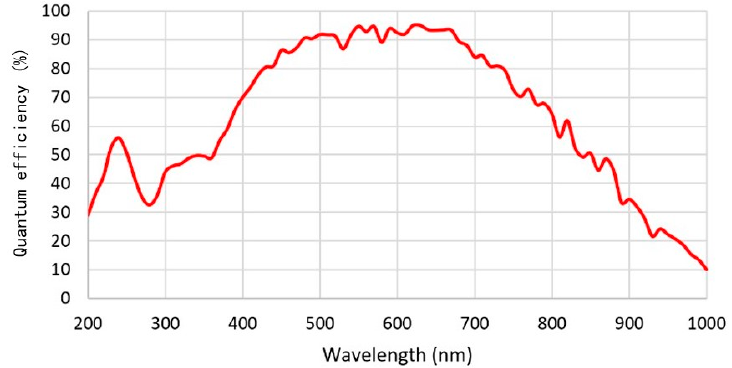
Figure 10. The relationship between the quantum efficiency of the detector and the